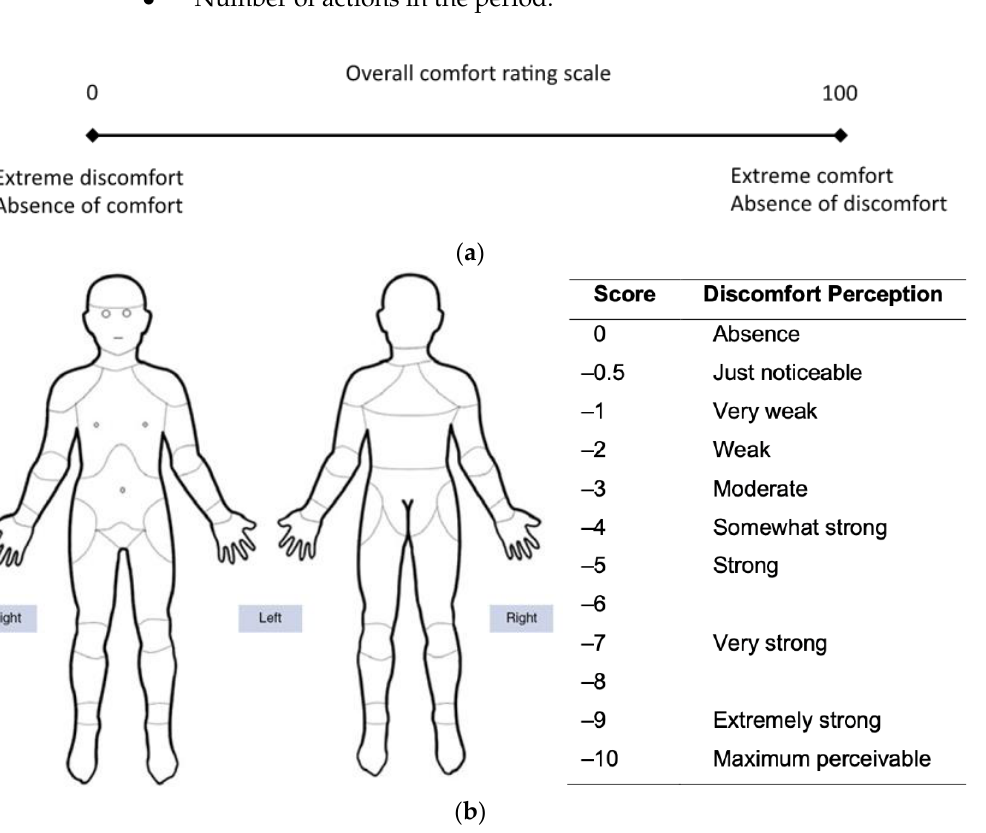
Figure 2. The comfort scoring charts system: ( a ) the 0-100 VAS scale to report a general comfort assessment and ( b ) the body part discomfort chart to report the eventually perceived discomfort in specific body areas and its intensity level.